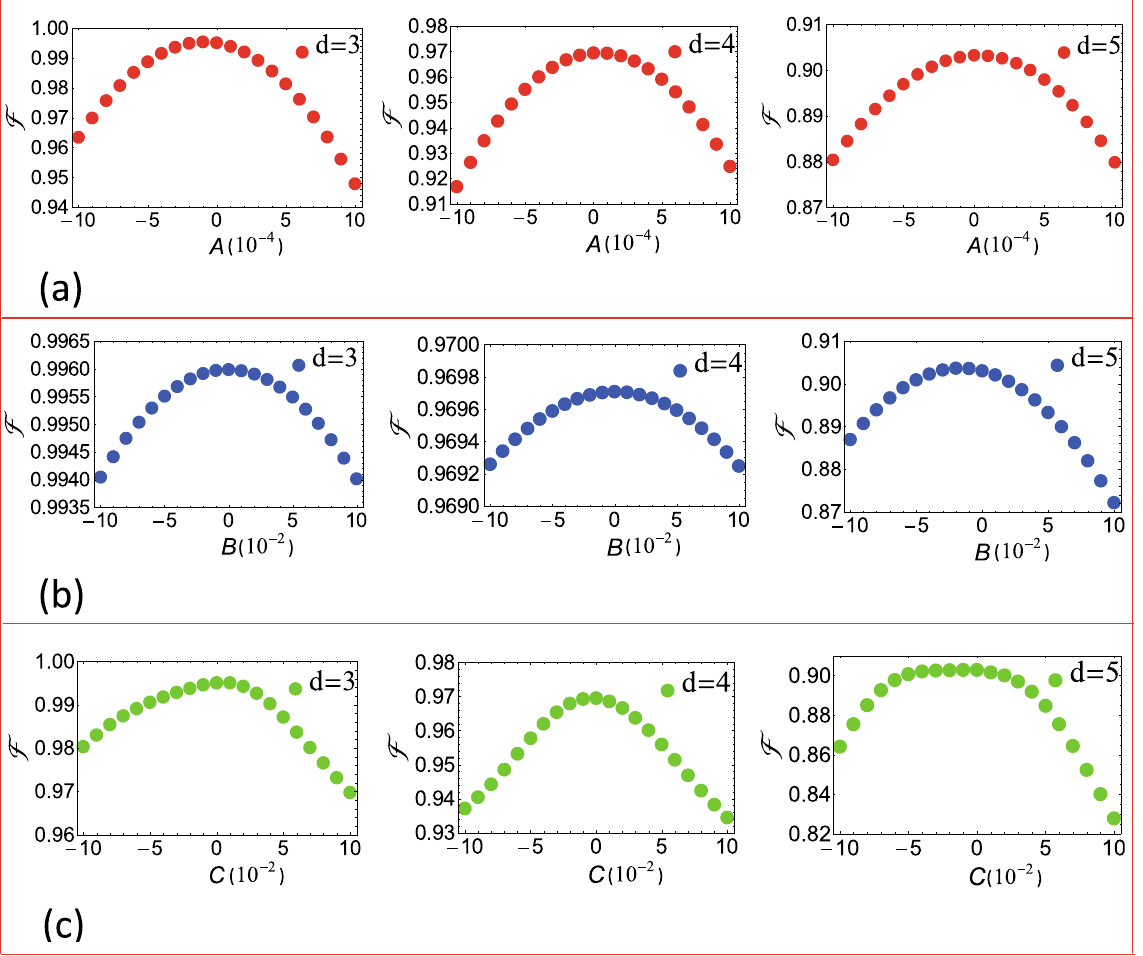
Figure 4. Fidelity versus A , B , and C for d = 3, d = 4, and d = 5, respectively. ( a ) Fidelity versus A . ( b ) Fidelity versus B . ( c ) Fidelity versus C